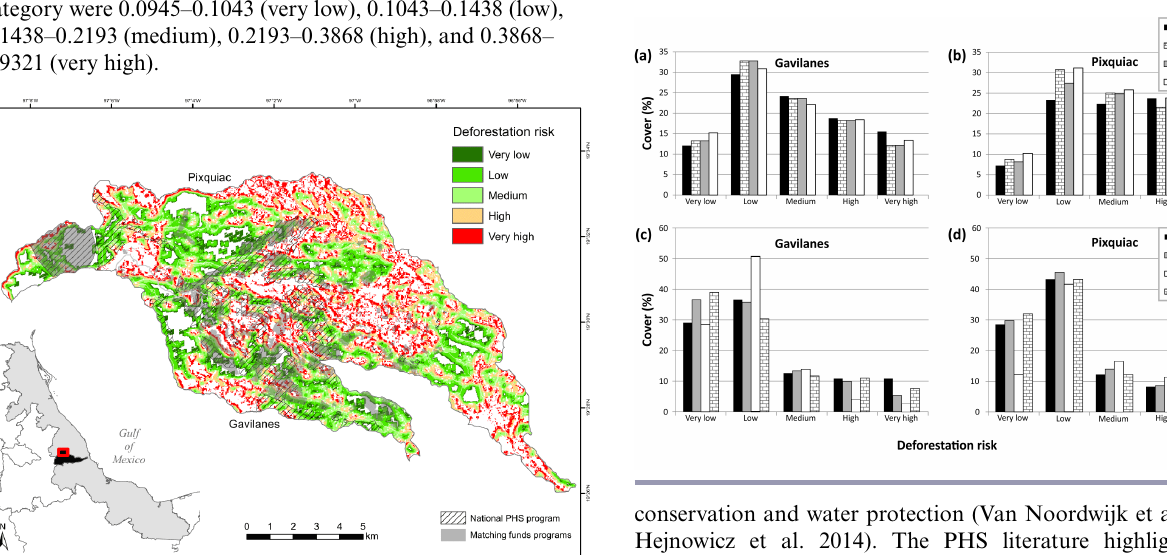
Fig. 4 . Comparison of the proportion of predicted deforestation risk within the Gavilanes (a) and Pixquiac (b) watersheds versus the coverage of land parcels receiving federal and local payments for hydrologic services (PHS) during the period 2003–2011; (a) and (b) include all forested areas; (c) and (d) include only cloud forest